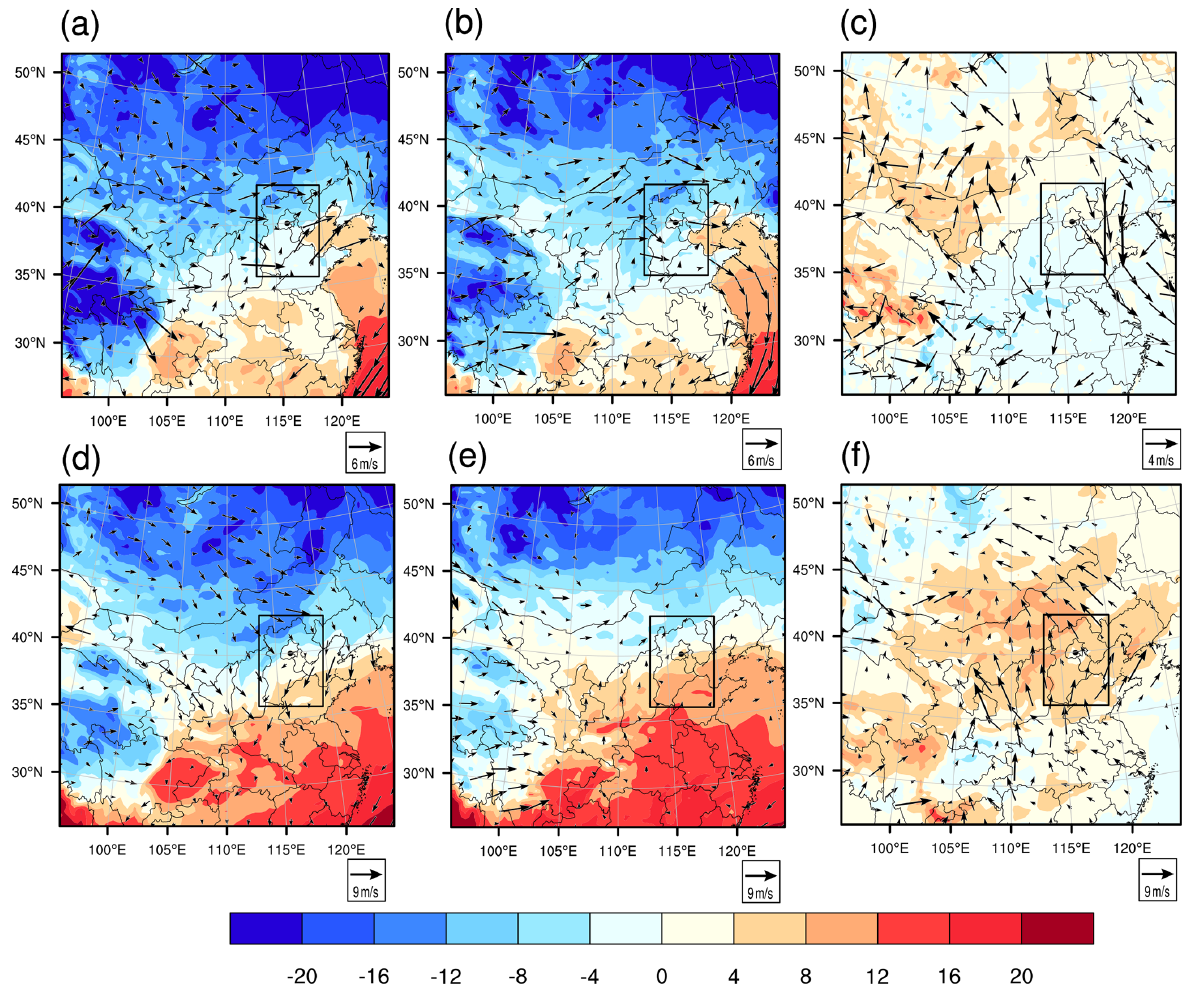
Figure 11. The wind (vector, ms − 1 ) and temperature field (shaded, ◦ ) forecasts at the ground level at the AT (with a lead time of 24h) of the (a) truth run and (b) control run. The differences in the wind and temperature fields between the truth run and control run (control run minus truth run) at the AT are shown in (c) . Panels (d–e) are the same as panels (a–c) but for the forests at the